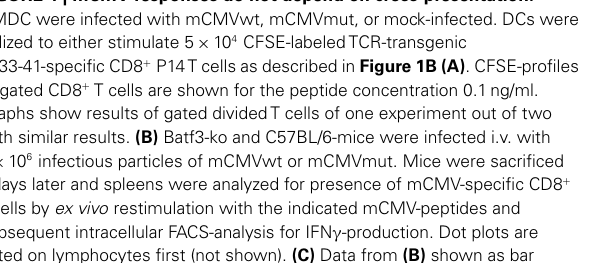
graphs are mean ± SEM from n = 3 mice per group. Open bars represent C57BL/6-wild type (wt) mice and filled bars represent Batf3-ko mice.This experiment has been repeated twice with similar outcome. (D) CD11c-Rac- or C57BL/6-mice were infected i.v. with 4 × 10 6 infectious particles of mCMVwt or mCMVmut. Mice were sacrificed 5days later and spleens were analyzed for presence of mCMV-specific CD8 + T cells by ex vivo restimulation with the indicated mCMV-peptides and subsequent intracellular FACS-analysis for IFN γ -production. Dot plots are gated on lymphocytes first (not shown). (E) Data from (D) shown as bar graphs are mean ± SEM from n = 3 mice per group. Open bars represent C57BL/6-wt mice, black bars represent Batf3-ko mice, gray bars are non-immunized controls.This experiment has been repeated twice with similar